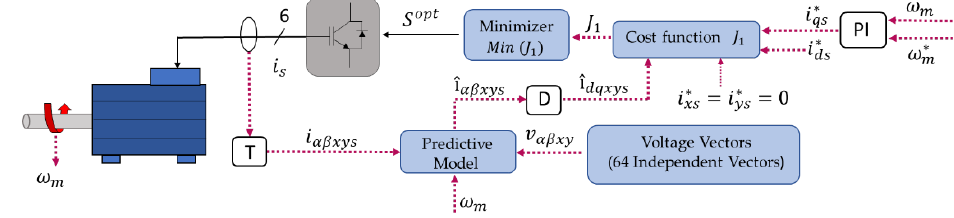
Figure 3. Standard MPC scheme for six-phase induction motor drives.